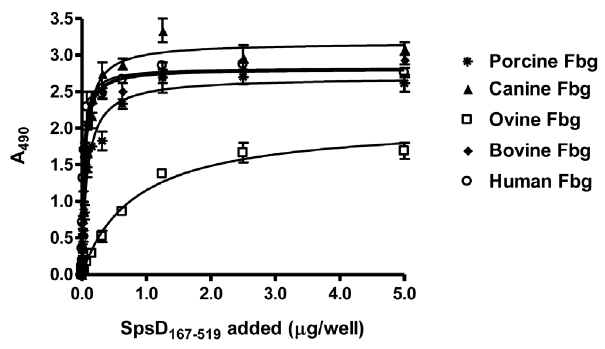
Figure 3. Dose-dependent binding of SpsD 167–519 to Fbg from different species. Microtiter wells were coated with human, canine, ovine, bovine and porcine Fbg overnight. The wells were probed with SpsD 167–519 followed by incubation with mouse anti-His-IgG and HRP- conjugated rabbit anti-mouse IgG. Values represent the means of triplicate samples 6 S.E. This experiment was performed three times with similar